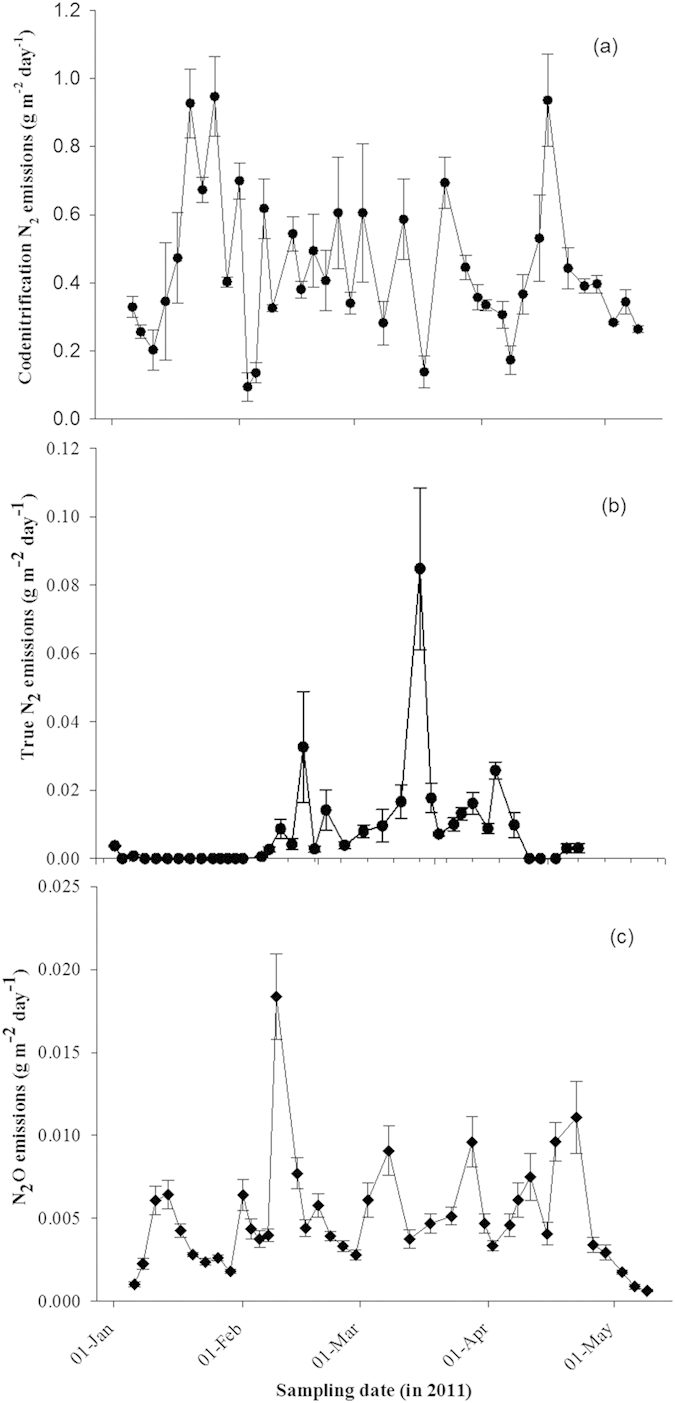
Mean daily N2 and N2O fluxes (g N m−2 day−1) (n = 4) from (a) co-denitrification (N2CO), and true denitrification (b) N2TRUE, and (c) N2OTRUE over a four month period following urine deposition. Error bar is the standard error of the mean (n = 4).